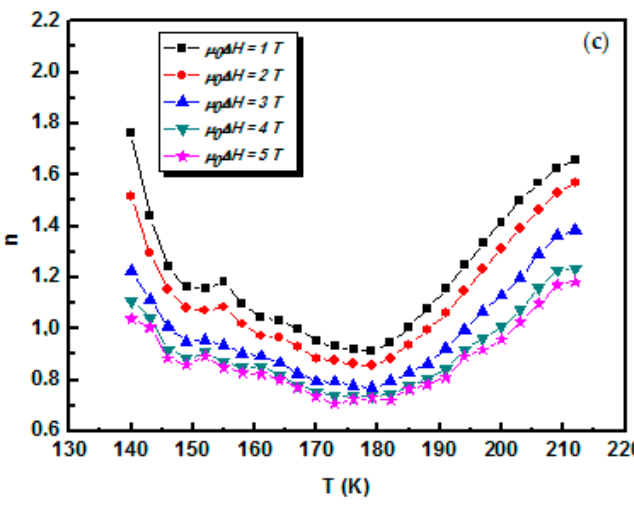
Figure 10. Temperature dependence of local exponent n measured at different field for La 0.8 Ca 0.2 Mn 1 − x Co x O 3 . ( a ) x = 0.1; ( b ) x = 0.2; ( c ) x =